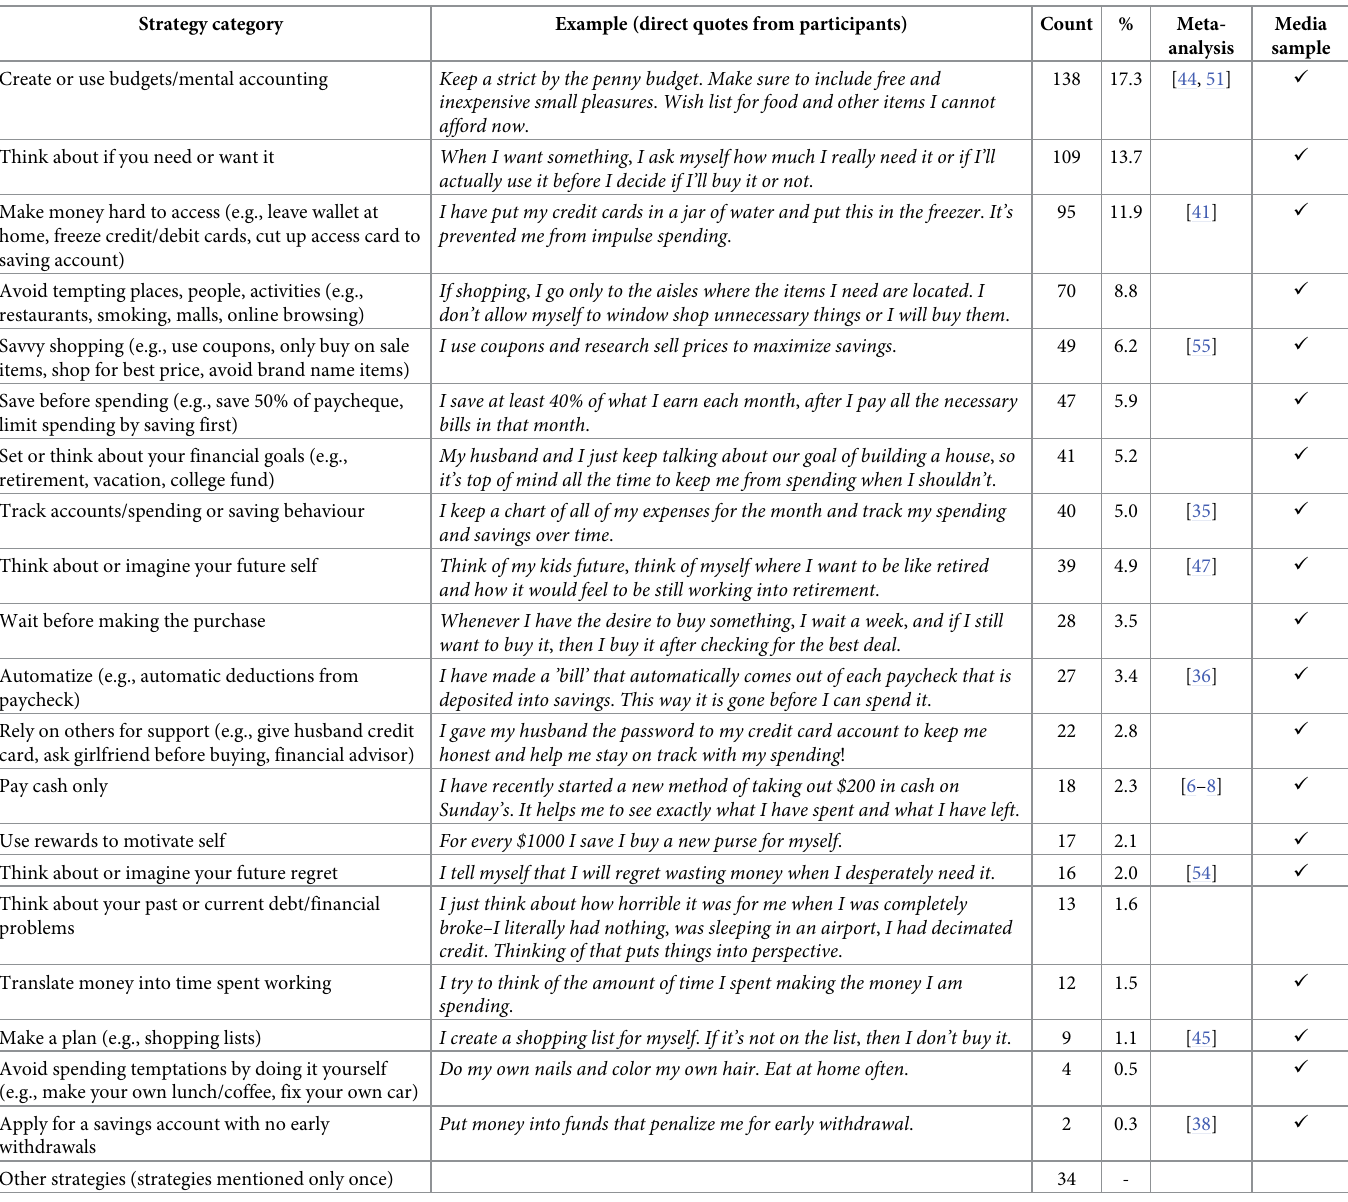
Table 4. Financial self-control strategies, examples, and frequency of mention in a lay person sample (Study 3). Strategy